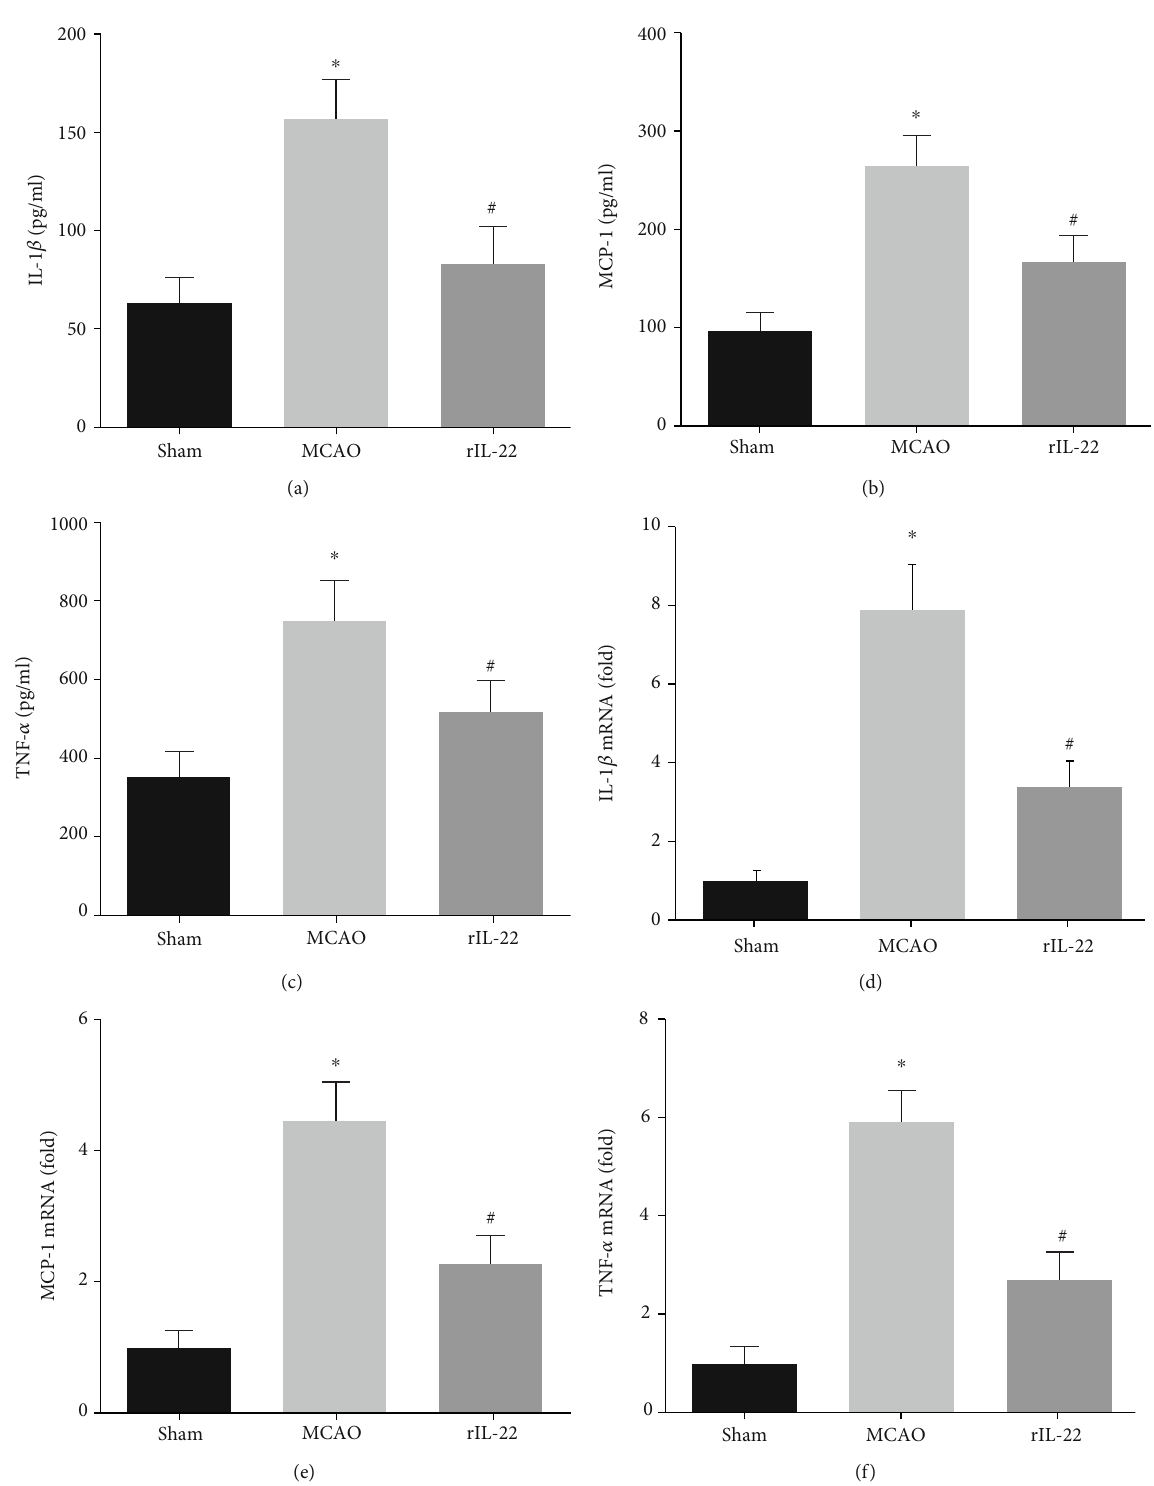
Figure 2: IL-22 treatment inhibited the in fl ammatory response after cerebral I/R injury. Serum levels of IL-1 β (a), MCP-1 (b), and TNF- α (c) were measured by ELISA ( n = 8 ). The mRNA expression of IL-1 β (d), MCP-1 (e), and TNF- α (f) was detected in brain tissues ( n = 8 ). ∗ P < 0 : 05 vs. sham group; # P < 0 : 05 vs. MCAO